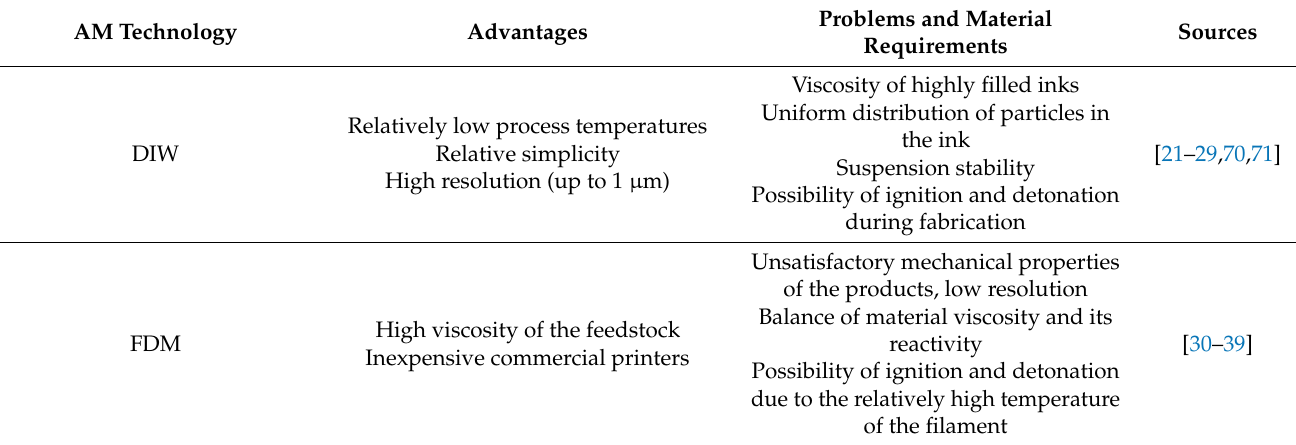
Table 1. Additive manufacturing technologies for HEMs and problems pertinent to their use. AM